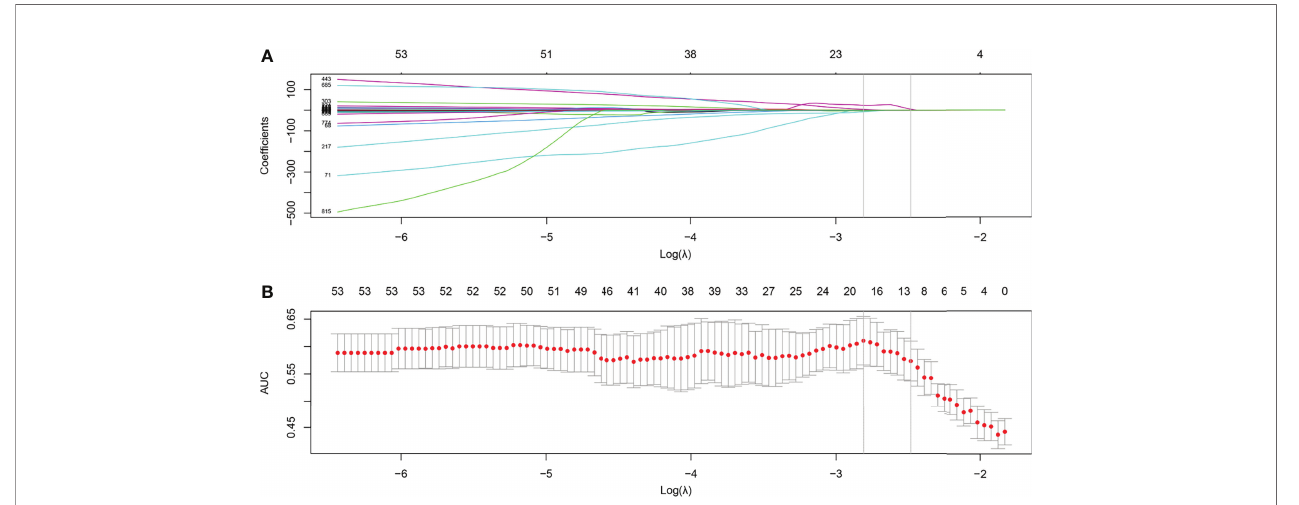
FIGURE 2 | Feature selection using the least absolute shrinkage and selection operator (LASSO) with a binary regression model. (A) The LASSO coef fi cient pro fi le was plotted using coef fi cients against log( l ). (B) Tuning parameter against parameter log( l ). The areas under the curve were depicted with corresponding l . The vertical lines are maximum and 1-standard error (1-se) criteria, respectively. As a result, 12 radiomics features with nonzero coef fi cients were selected using 1-se